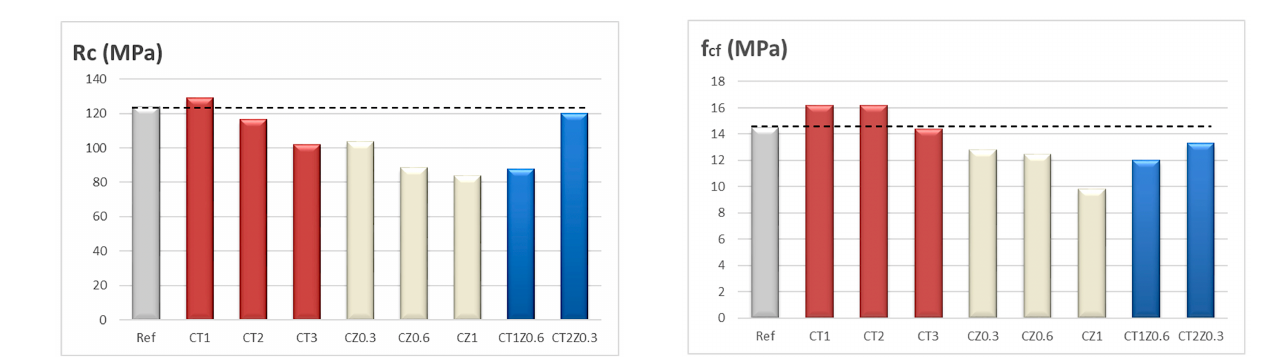
Figure 2. Compressive strength of HPC samples. Figure 3. Flexural strength of HPC